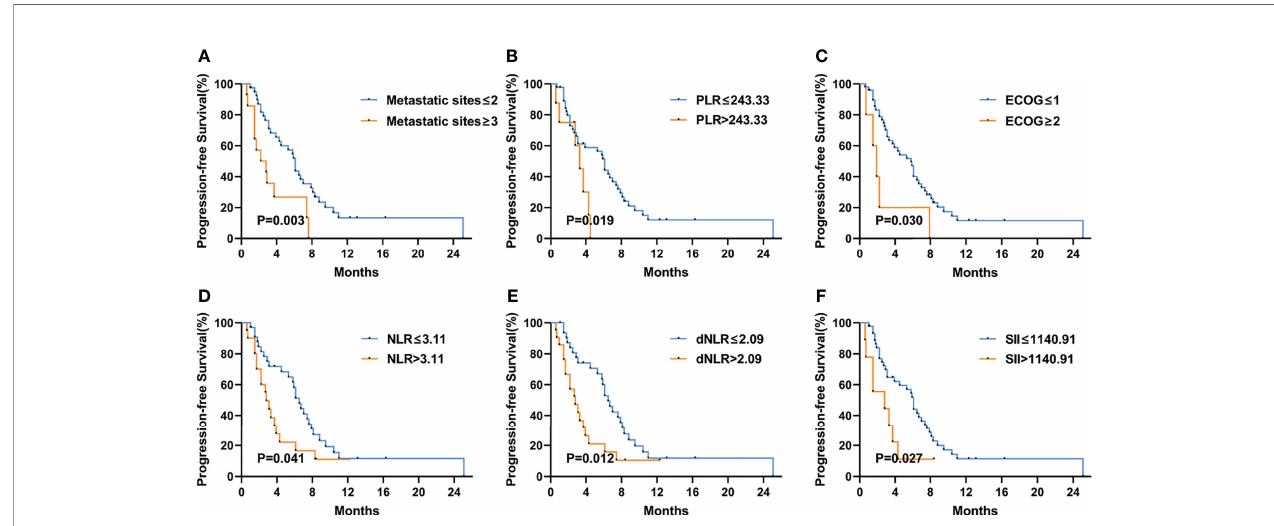
FIGURE 4 | Kaplan – Meier curves of progression-free survival (PFS) in the second-line or posterior treatment according to metastatic sites (A) , PLR (B) , ECOG PS (C) , NLR (D) , dNLR (E) , and SII (F) at baseline. The P values were calculated using the log-rank test (two-sided).